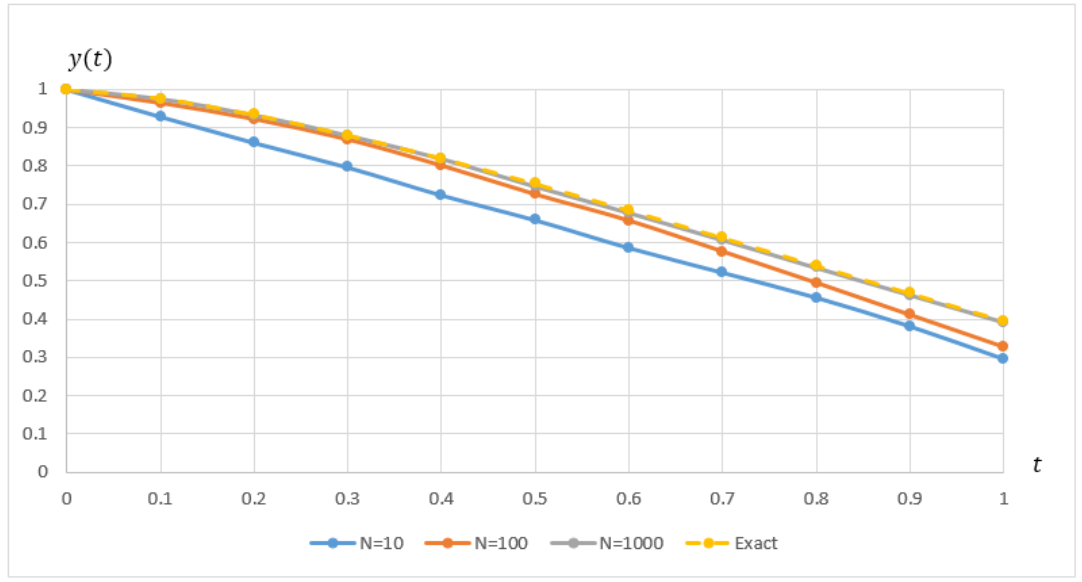
Figure 5. Approximate solution, y ( t ) against each point, t at different N of α = 1.50 when solving Example 1 using